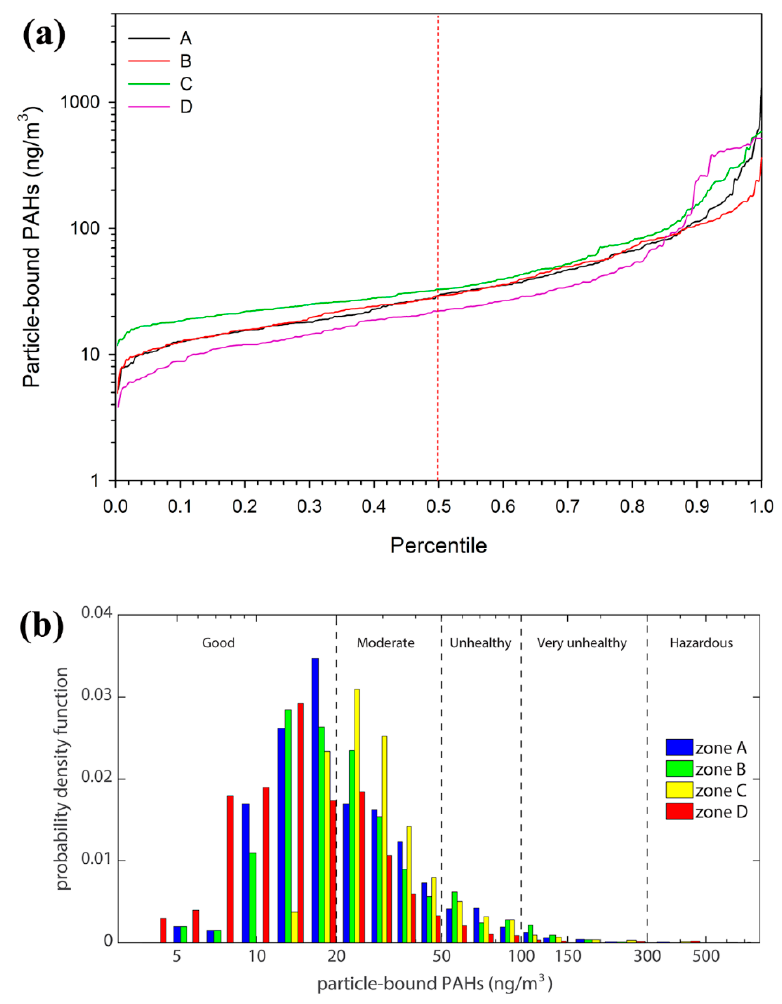
Figure 5. ( a ) Cumulative distributions and ( b ) probability density functions of cell-based pPAH concentrations for zone A, B, C, and D. The number of concentration ranges in the probability density functions is 22.